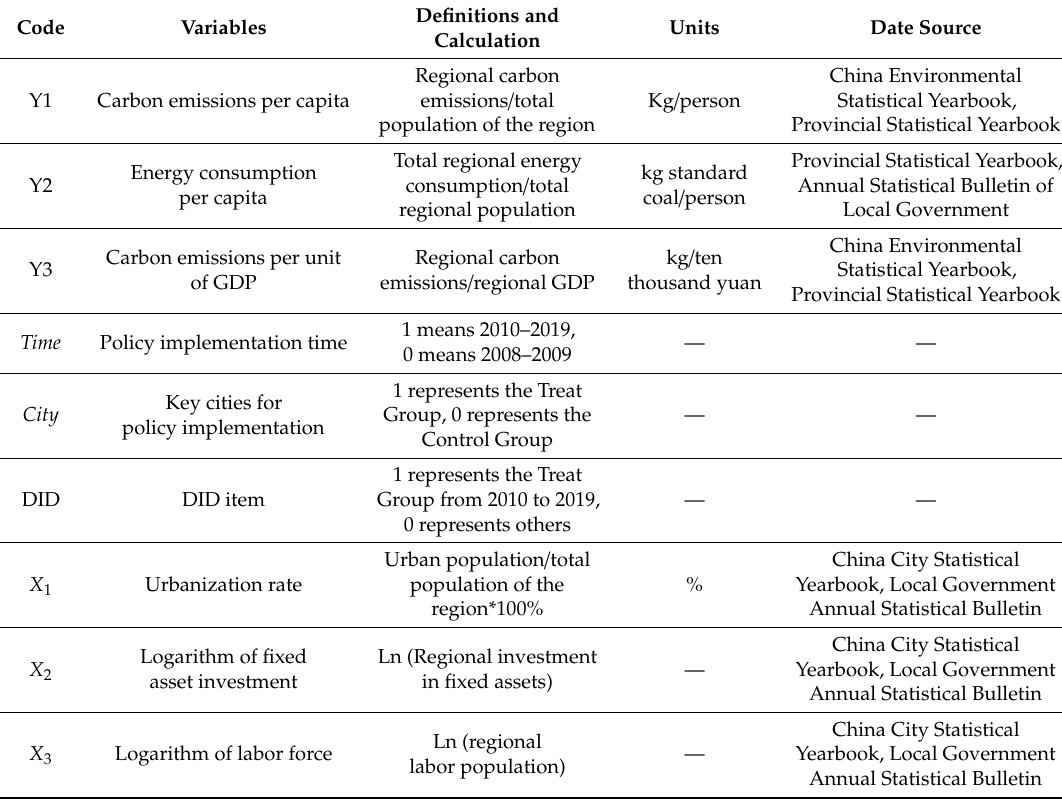
Table 1. Definitions and calculation formulas of